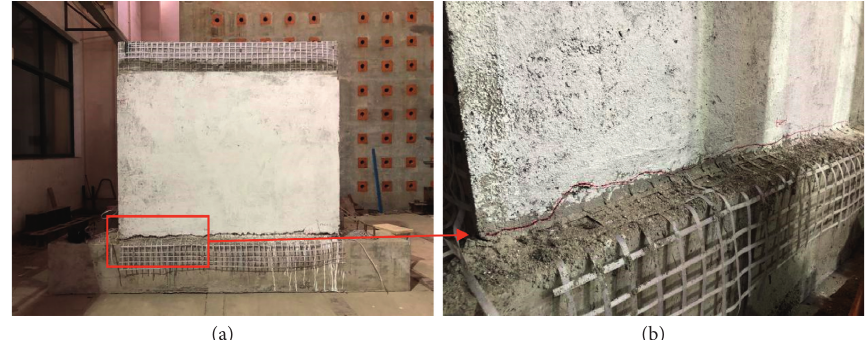
Figure 9: Damage mode of unstrengthened specimen JW-2. (a) Overall damage and (b) local cracks. Table 3: Cracking load and ultimate load values of specimens.